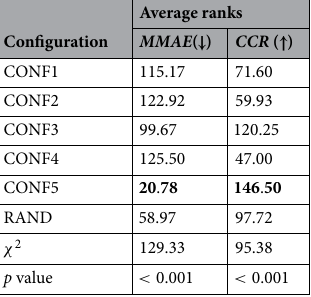
Table 3. Kruskal–Wallis statistical test results for CCR and MMAE (test set). The best results are shown in bold. The second best results are shown in